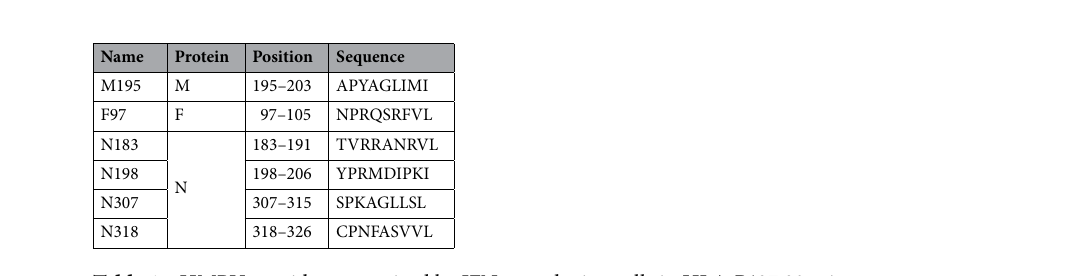
Table 1. HMPV peptides recognized by IFNγ-producing cells in HLA-B*07:02